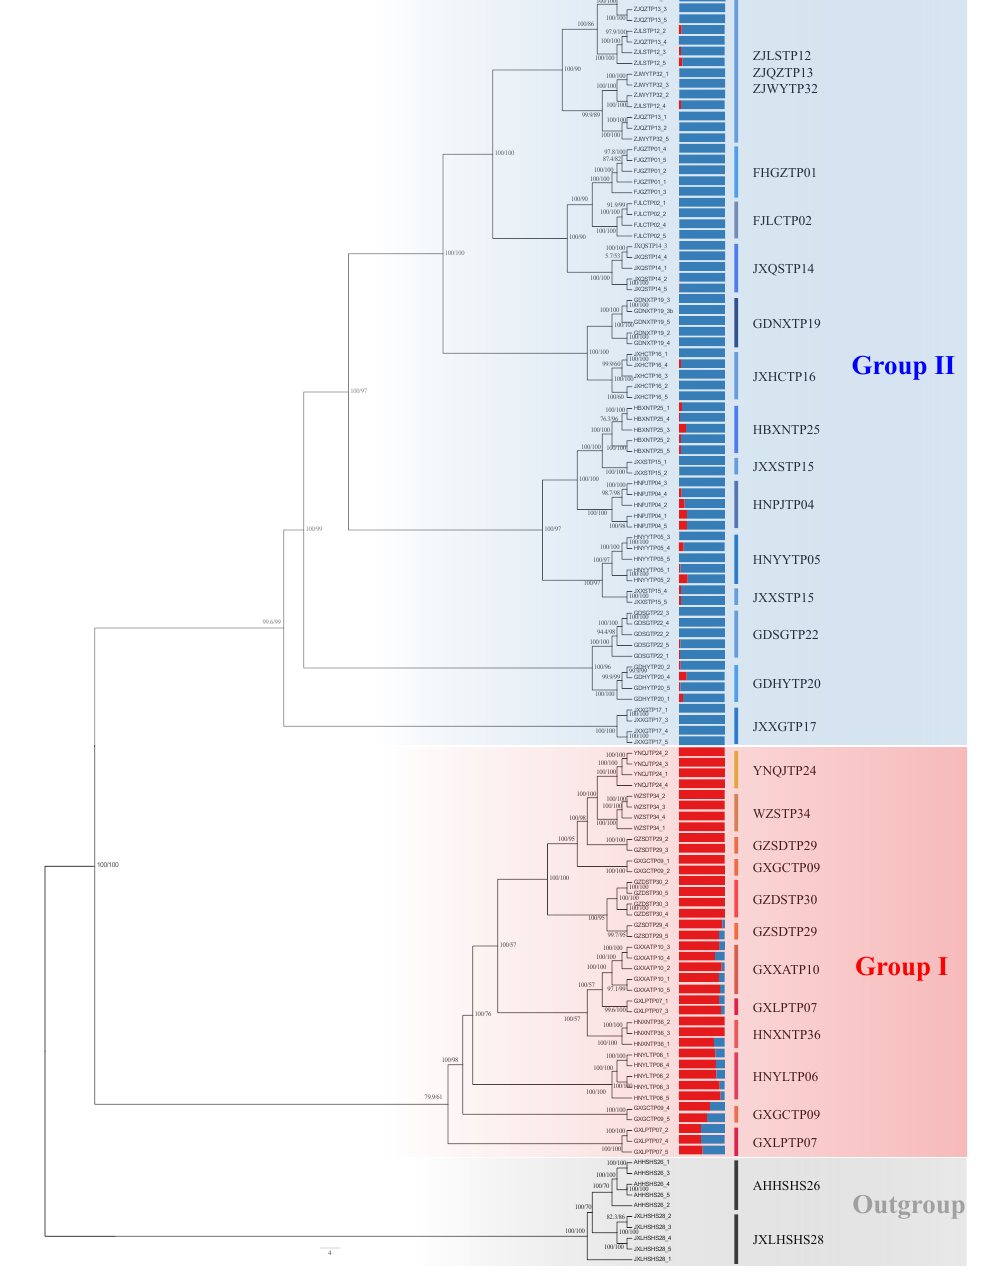
Figure 2. ML phylogenetic tree of the D. catenatum accessions and model-based clustering with K from 2. Numbers near the nodes are bootstrap